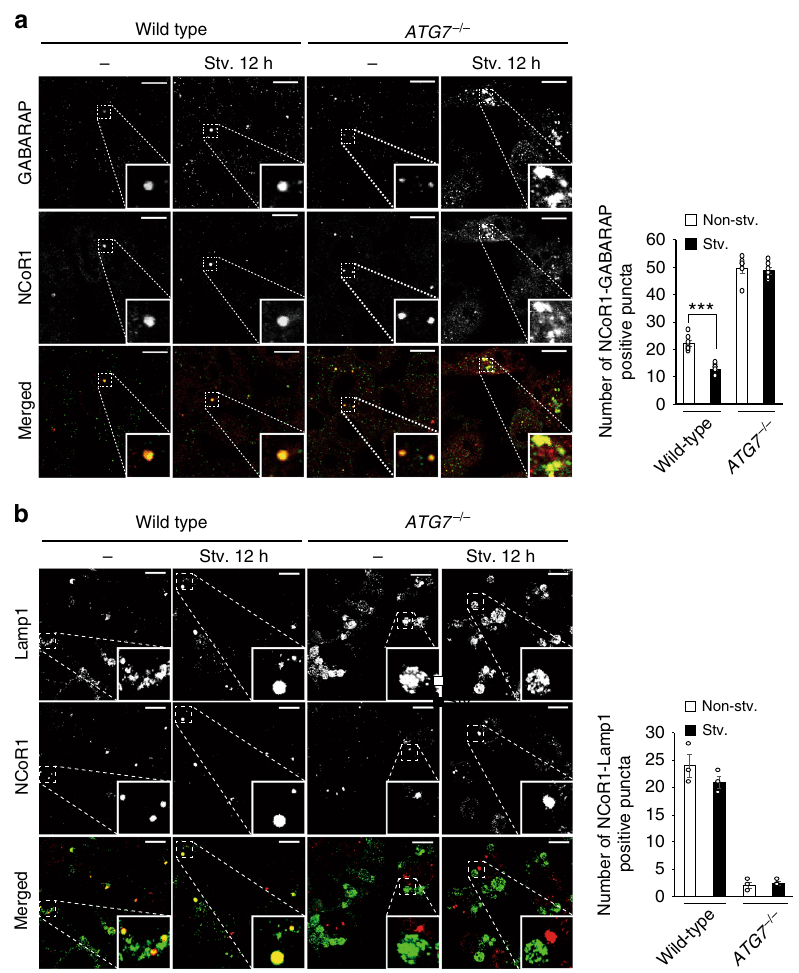
Fig. 7 Localization of NCoR1 on GABARAP-positive structures. a , b Immuno fl uorescence analysis. Wild-type or ATG7 -de fi cient HepG2 cells were cultured under nutrient-rich or -poor conditions, and then immunostained with anti-GABARAP and anti-NCoR1 ( a ) or anti-Lamp1 and anti-NCoR1 antibodies ( b ). The number of cytoplasmic NCoR1 and GABARAP or of cytoplasmic NCoR1 and Lamp1 double-positive dots per 20 cells was counted. The experiments were performed three times. Data are means± s.e.m. *** P < 0.001 as determined by Welch ’ s t -test. Each inset is a magni fi ed image. Bar: 2.5 μ